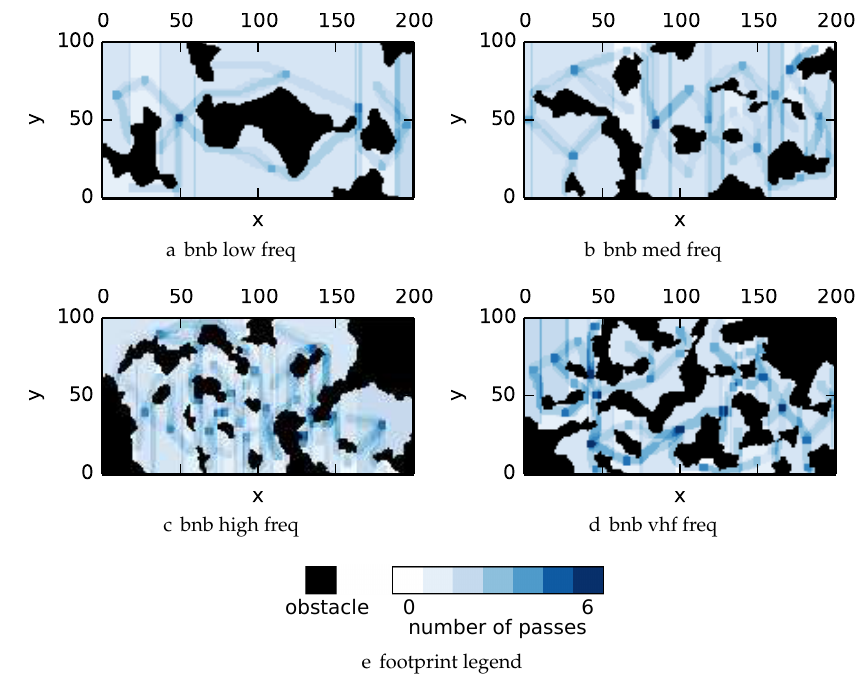
Figure 11. Multipass coverage plans in environments with uniform information for the (cid:101) -admissible B&B algorithm.